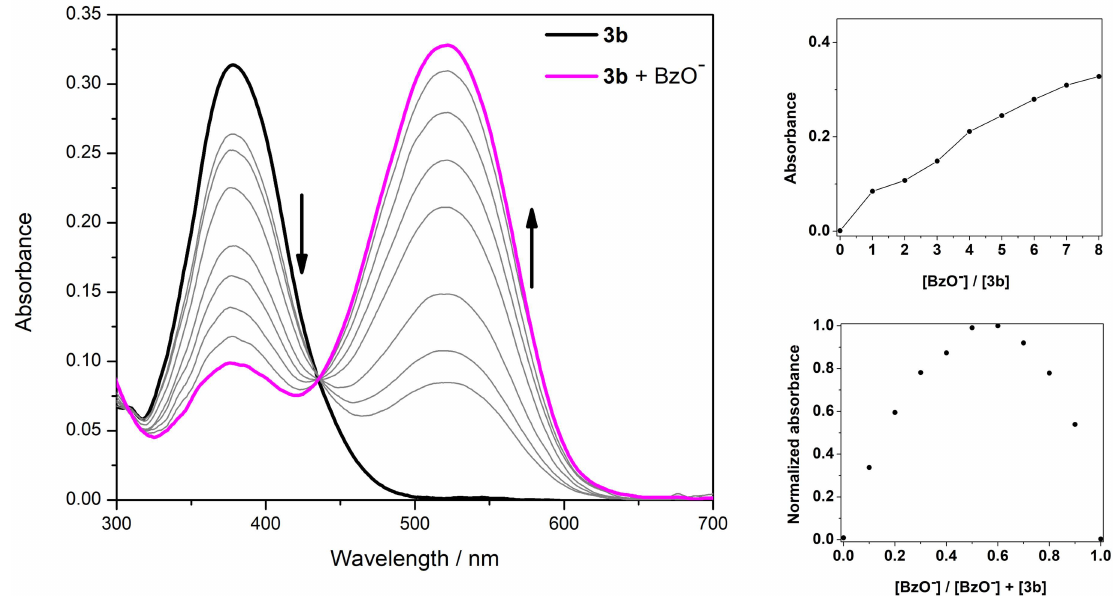
Figure 4. Photophysical interaction between compound 3b and BzO − (8 equiv. of BzO − required for maximum absorbance). Left —spectrophotometric titration of compound 3b with BzO − ; Top right —absorbance at 520 nm as a function of added ion equiv.; Bottom right —Job’s plot for the interaction (stoichiometry 3b 1:1 BzO − ).